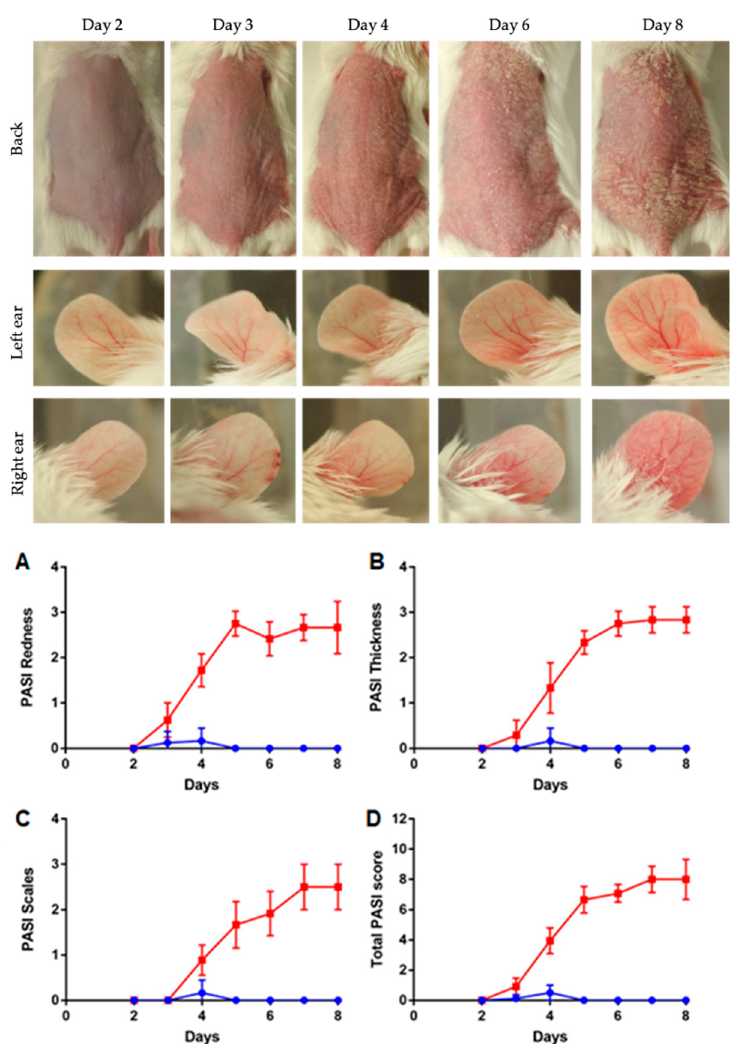
Figure 2. ( up ) Evaluation of dorsal skin and ears following IMQ cream application, from day 2 to day 8. Left ear was negative control, with no IMQ applied. ( down ) Evaluation of PASI score in the course of IMQ induction of psoriasis-like dermatitis. Observed criteria are skin redness ( A ), thickness ( B ), the presence of scales ( C ) and total PASI score ( D ). Psoriatic mice are presented with red squares, control mice with blue rounds. Data is presented as mean ± SD ( n = 15 for day 1 and decreased subsequently to n = 3 for day 8).